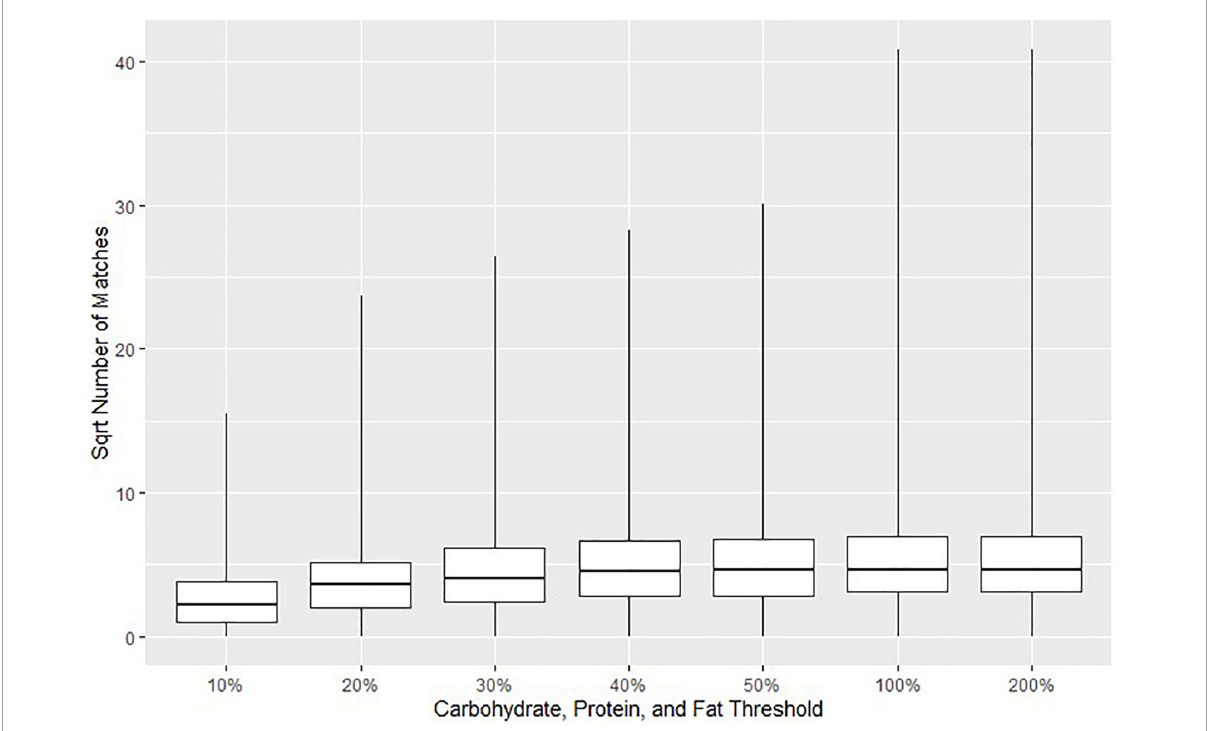
FIGURE2 Boxplots indicating the 0th, 25th, 50th, 75th, and 100th percentiles of the square roots of the numbers of Canadian Nutrient File (CNF) suggested matches for all Euromonitor products as a function of the threshold selection for carbohydrates, proteins, and fats. The threshold for fiber, saturated fat, and sugar was set to 40% in all cases, and the sodium threshold was set to 50%. Fuzzy string matching was not used. The square root number of matches is reported due to the large numbers of matches when using higher